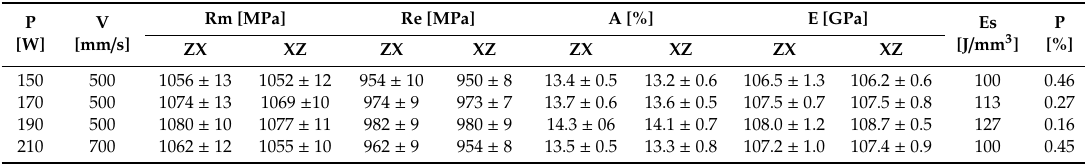
Table 4. List of DMLS parameters and properties of Ti6Al4V alloy heat treated at 850 ◦ C meeting the criteria of ASTM F 1142 standard for implantable